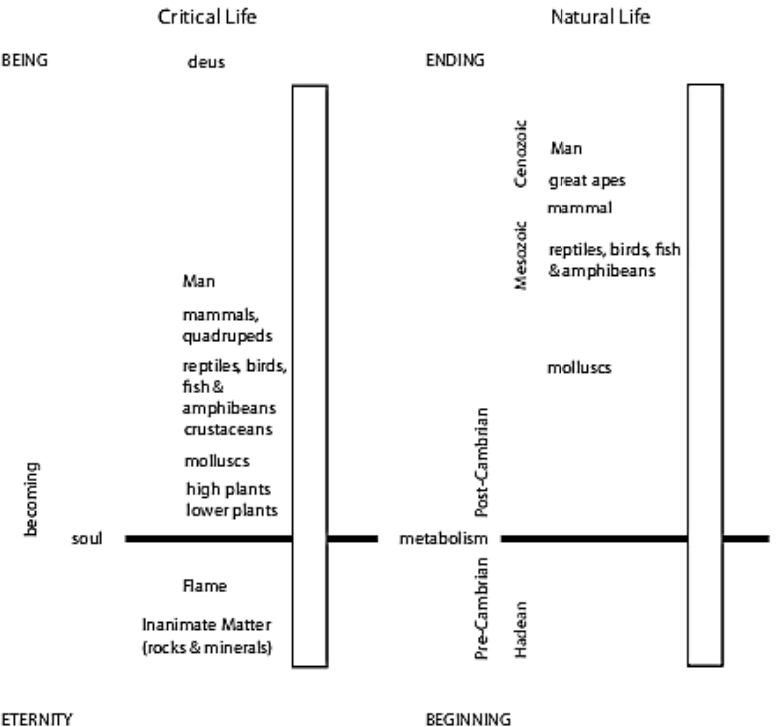
Fig. 1 The Explications between Critical Life and Natural Life (Povinelli, 2016, p. 48)